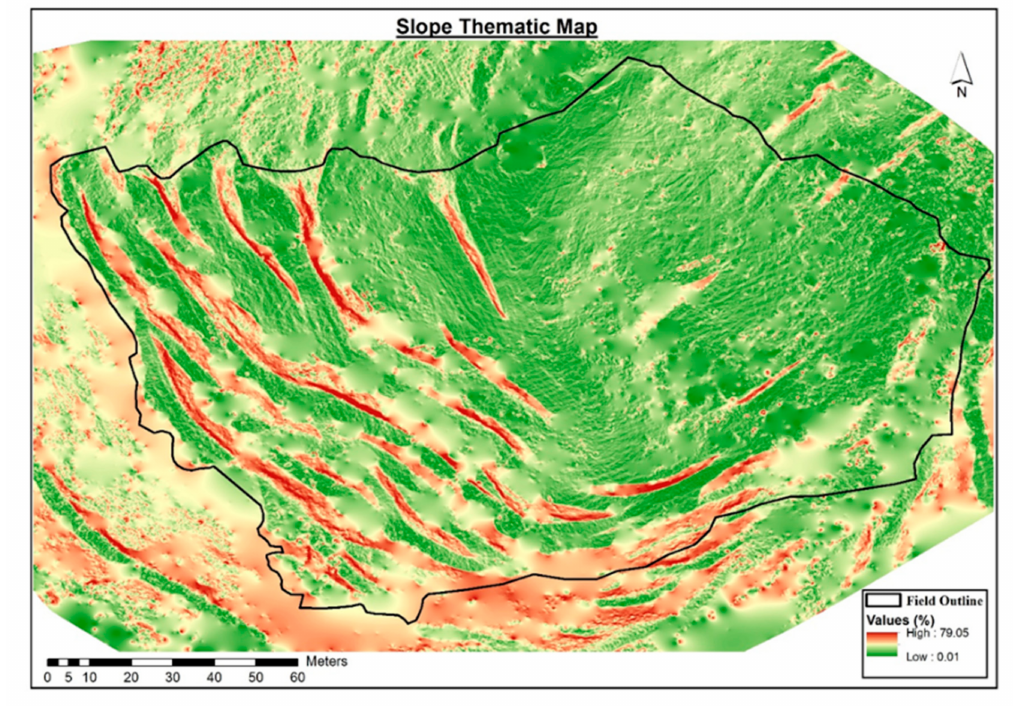
Figure 2. Slope Thematic Map of the study area.